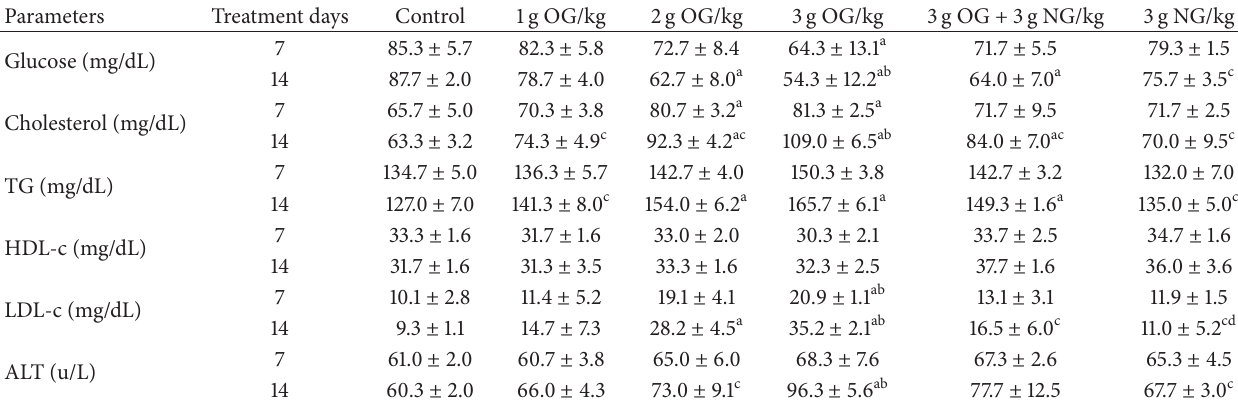
Table 3: Effects of coadministration of unoxidized and oxidized desi ghee on the changes in serum biochemical parameters of rabbits. Parameters